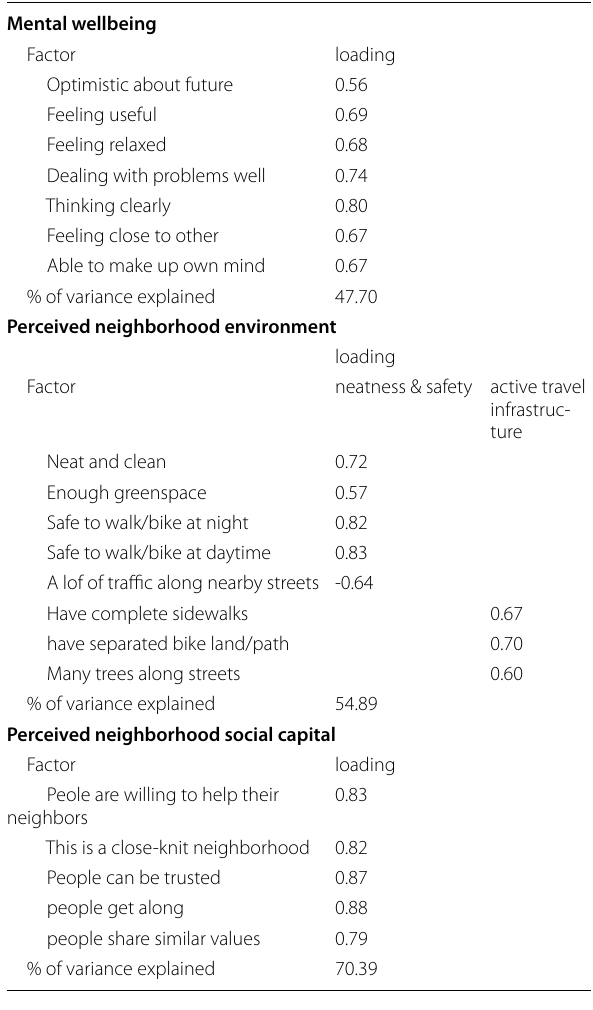
Table 1 Principal component